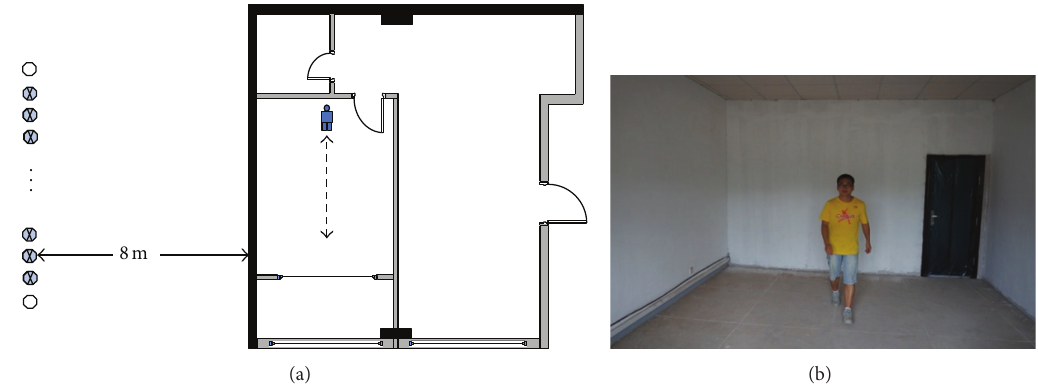
Figure 9: One person walked in the bedroom. (a) Track of the movement. (b) Photo of the scene when one person was walking 2m behind the wall in